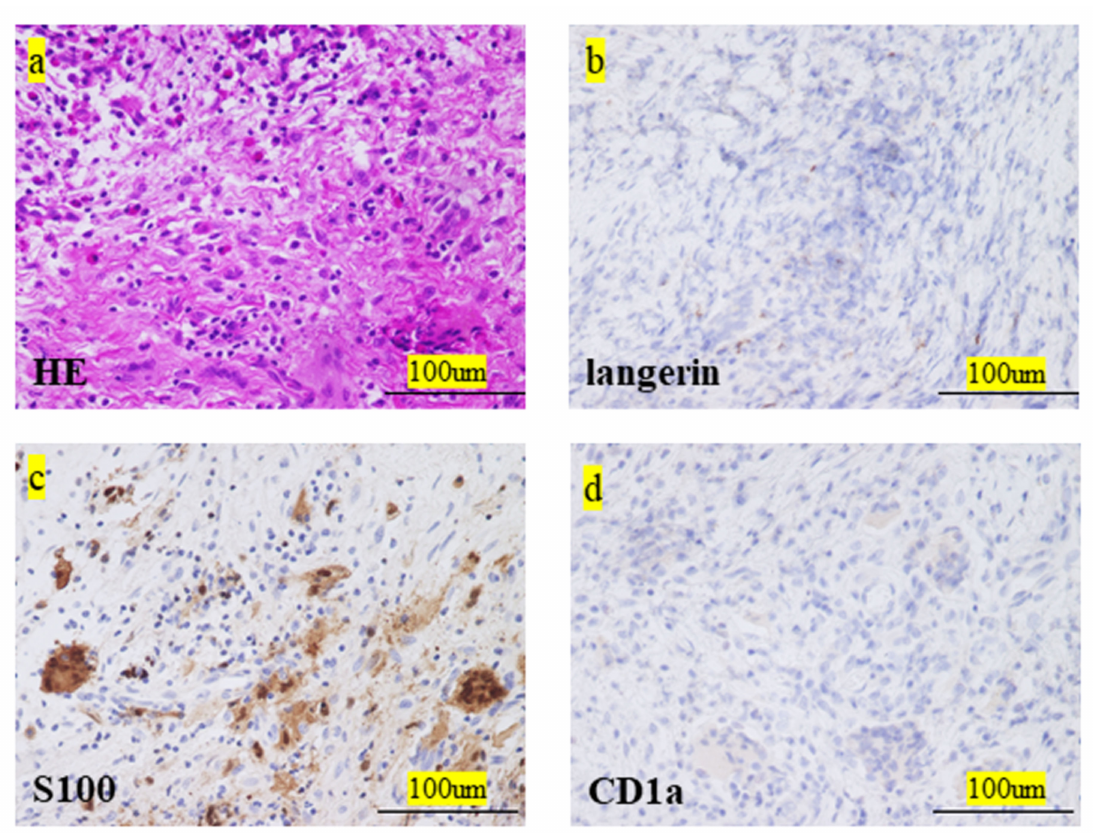
Figure 3. ( a ) Histological examination of H-E stained sections. ( b ) Immunohistochemical staining examination for langerin ( c ) and S-100 was positive. ( d ) Immunohistochemical staining examination for CD-1a was negative. H-E,